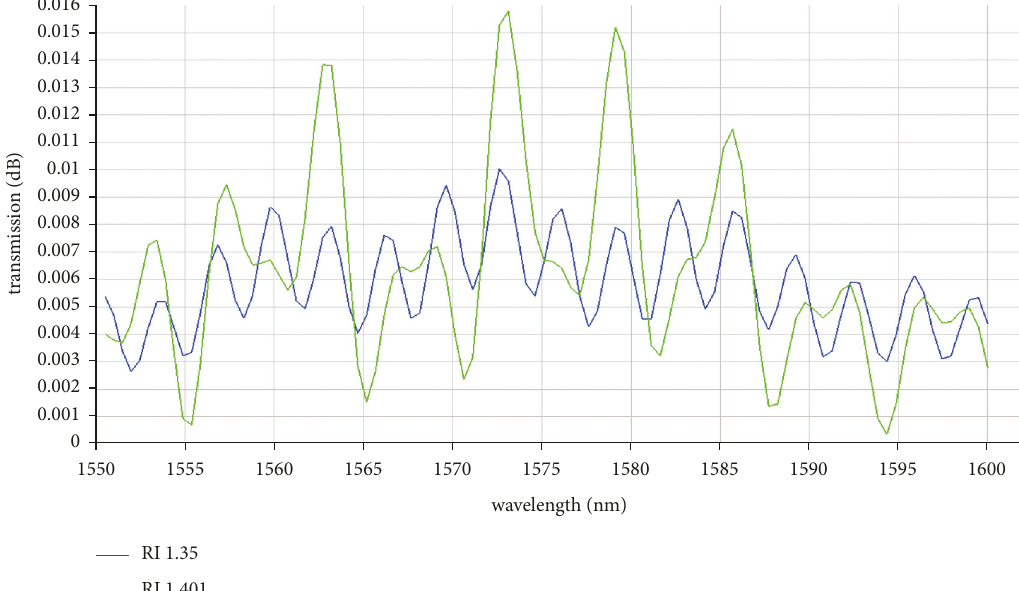
Figure 6: Silicon nitride rib-slot waveguide transmission spectrum of normal cells with refractive index 1.35 vs. Breast Cancer (MCF-7) cells with refractive index of 1.401 with integrated analyte thickness of 400nm, 250nm, 150nm, and